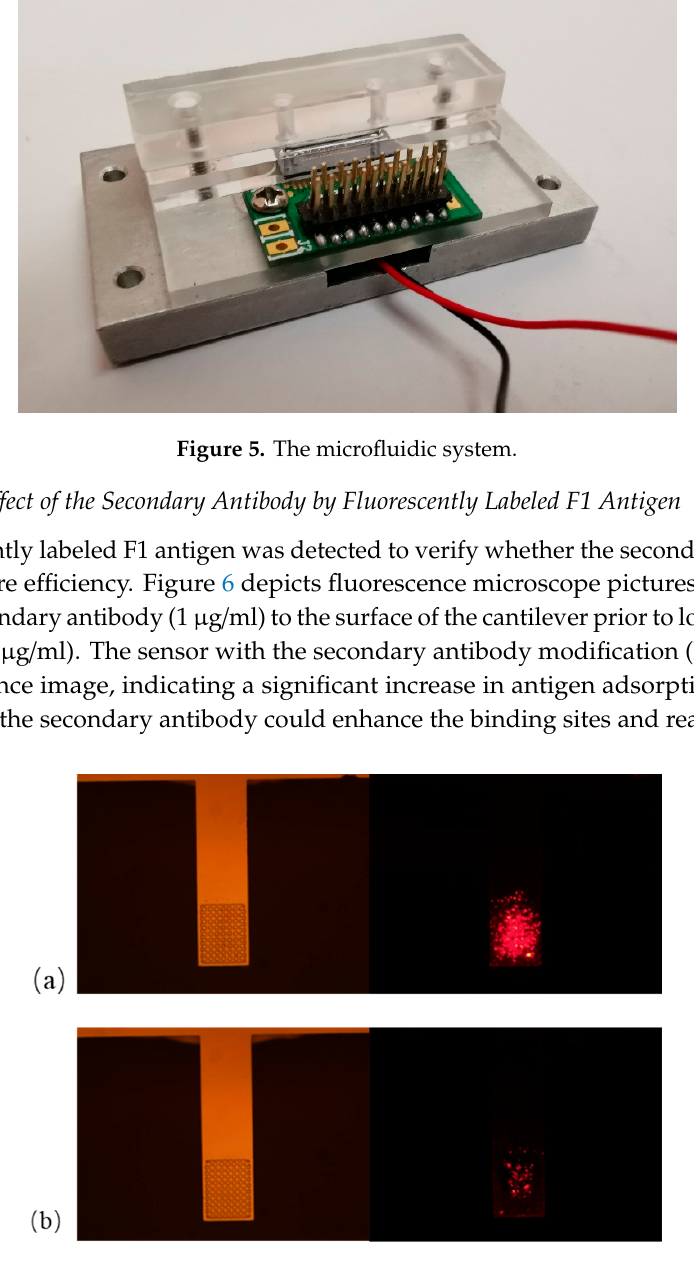
Figure 4. COMSOL simulation results of microchannel height (flow rate f r = 1 mL/min).